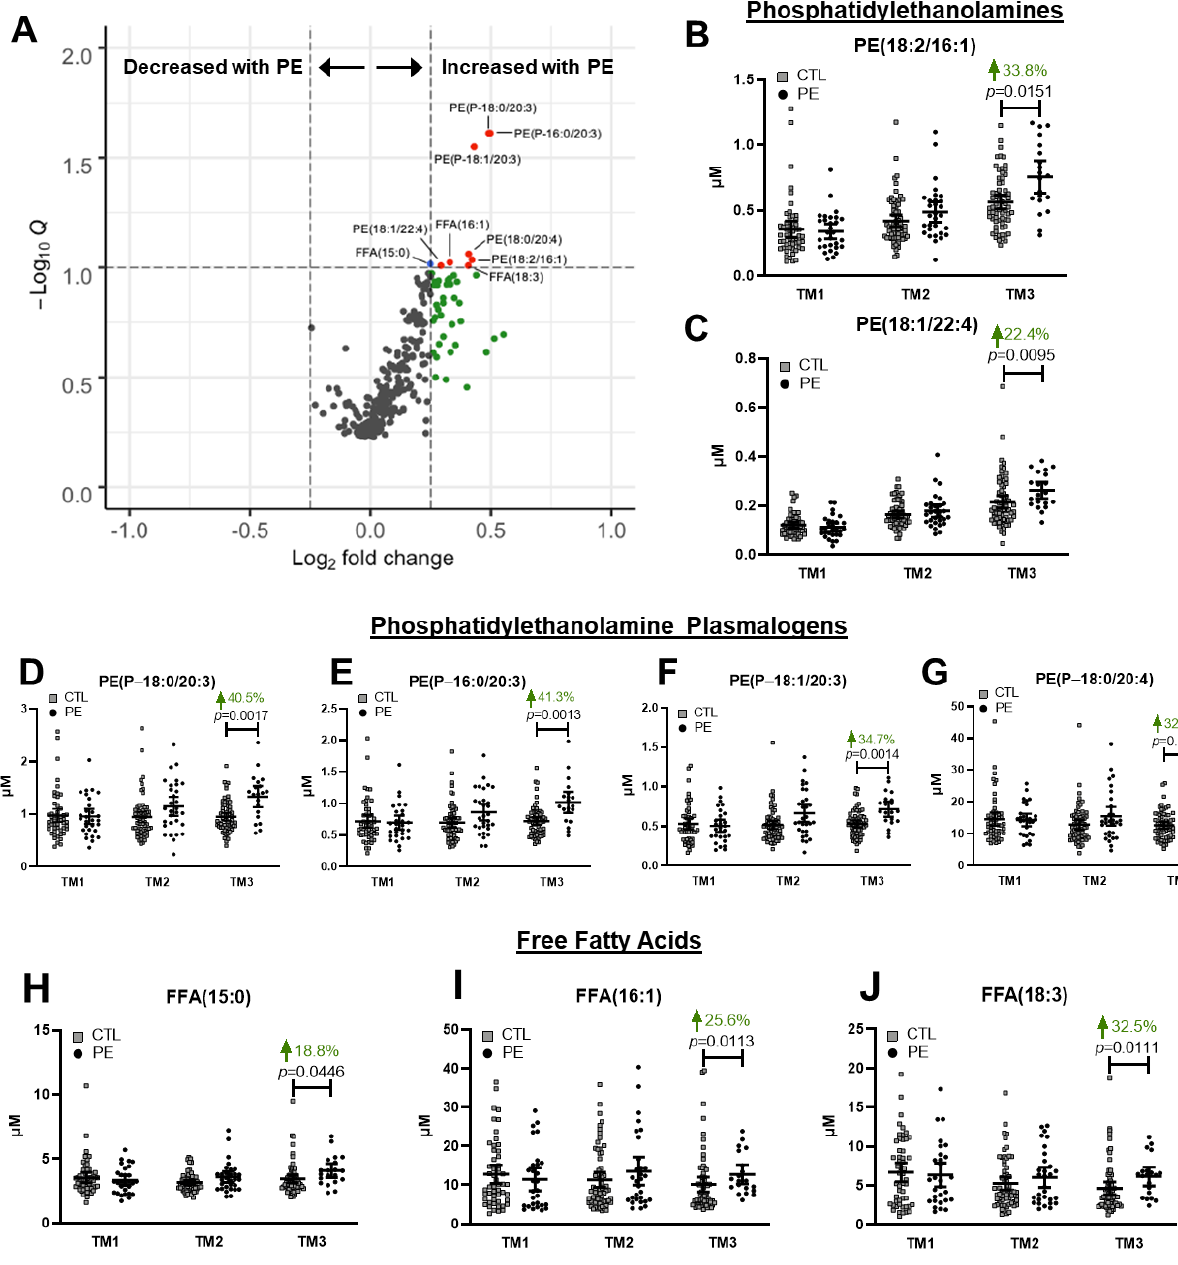
Figure 2. Individual lipid species elevated in the third trimester of PE pregnancies. ( A ) Volcano plot of 280 individual lipid species profiled in the third trimester of pregnancy. The x-axis indicates the log2 fold change relative to the CTL group. The y-axis shows the negative log 10 of the false discovery rate (q-value). Red points are lipid species with log2FC > 0.25 and q < 0.1. Blue points have q < 0.1. Green points have log2FC > 0.25. Lipid species with q < 0.1 are labeled. ( B – J ) Concentrations of individual lipid species (q < 0.1) in PE and CTL groups at each trimester of pregnancy. p -values are derived from Šídák’s multiple comparisons test following linear mixed effects modeling. Error bars represent 95% confidence intervals.